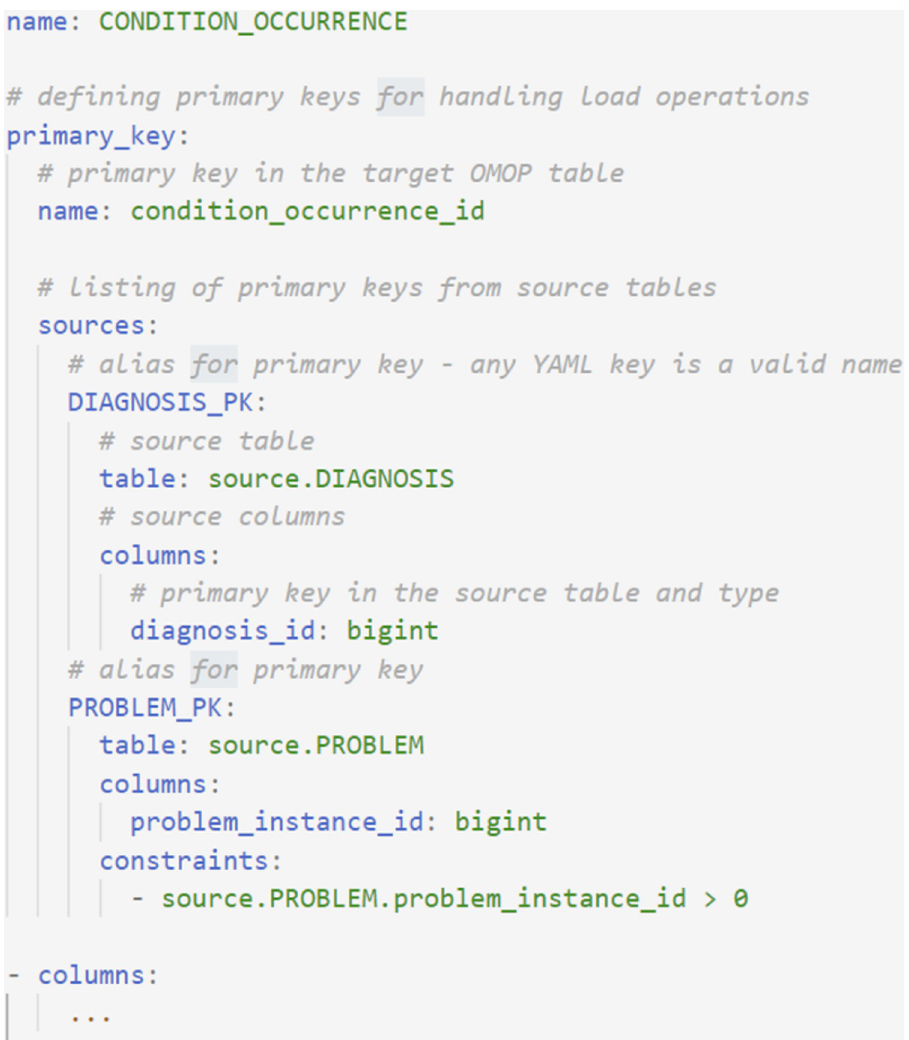
Fig 3. Definition of primary keys in YAML. Definition of the primary key for the OMOP CONDITION_OCCURRENCE table, which is populated—in the illustrated example—with the data from two source tables: DIAGNOSIS and PROBLEM. For the framework to handle the load operations, the primary keys of each source table must be defined under the sources YAML